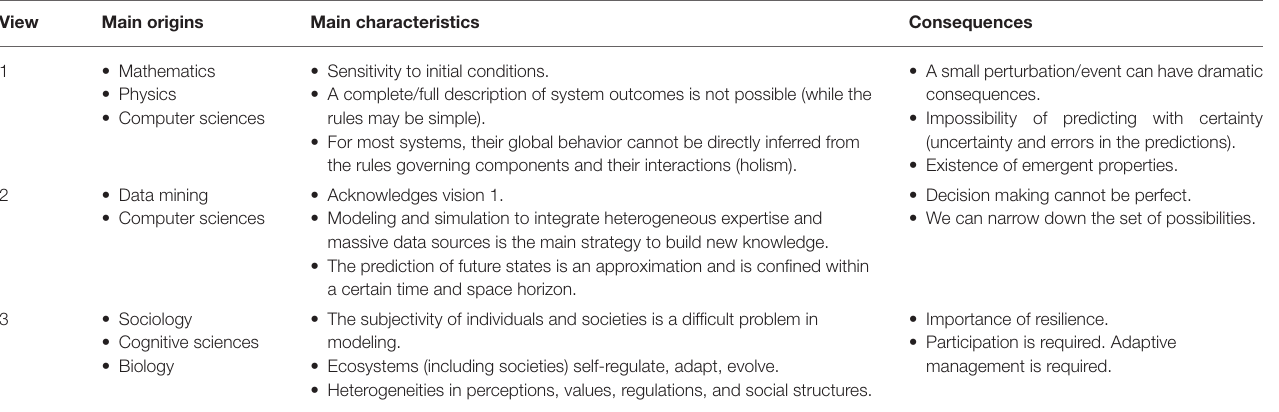
TABLE 1 | Three views of complexity and their implications for IAH implementation—Elaborated from (23).